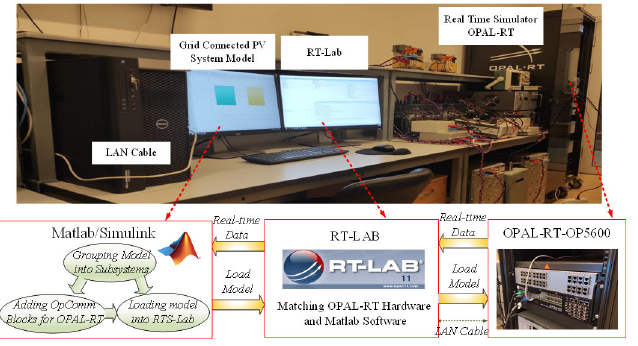
Figure 9. Real-time experimental